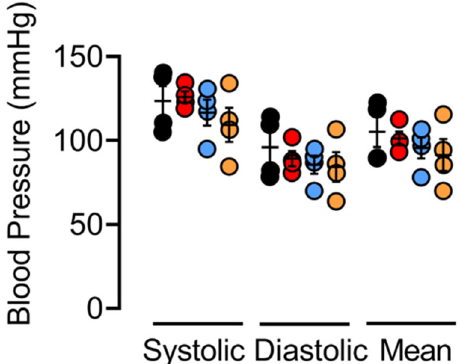
Fig. 8 | AMPK- α 1/ α 2 deletion in smooth muscles had little or no effect on sys- temic arterial blood pressures. Dot plots show mean±SEM for systolic, diastolic andmeansystemicarterialbloodpressuresunderresting conditionsforAMPK- α 1/ α 2 fl oxed (AMPK- α 1/ α 2 FLX, black, n =4 mice), AMPK- α 1 knockout (AMPK- α 1 KO, red, n =4 mice), AMPK- α 2knockout (AMPK- α 2KO, blue, n =4mice) and AMPK- α 1/ α 2 knockout (AMPK- α 1/ α 2 KO, orange, n =4 mice). Statistical signi fi cance was assessed by Kruskall Wallis ’ test with Dunn ’ s correction for multiple